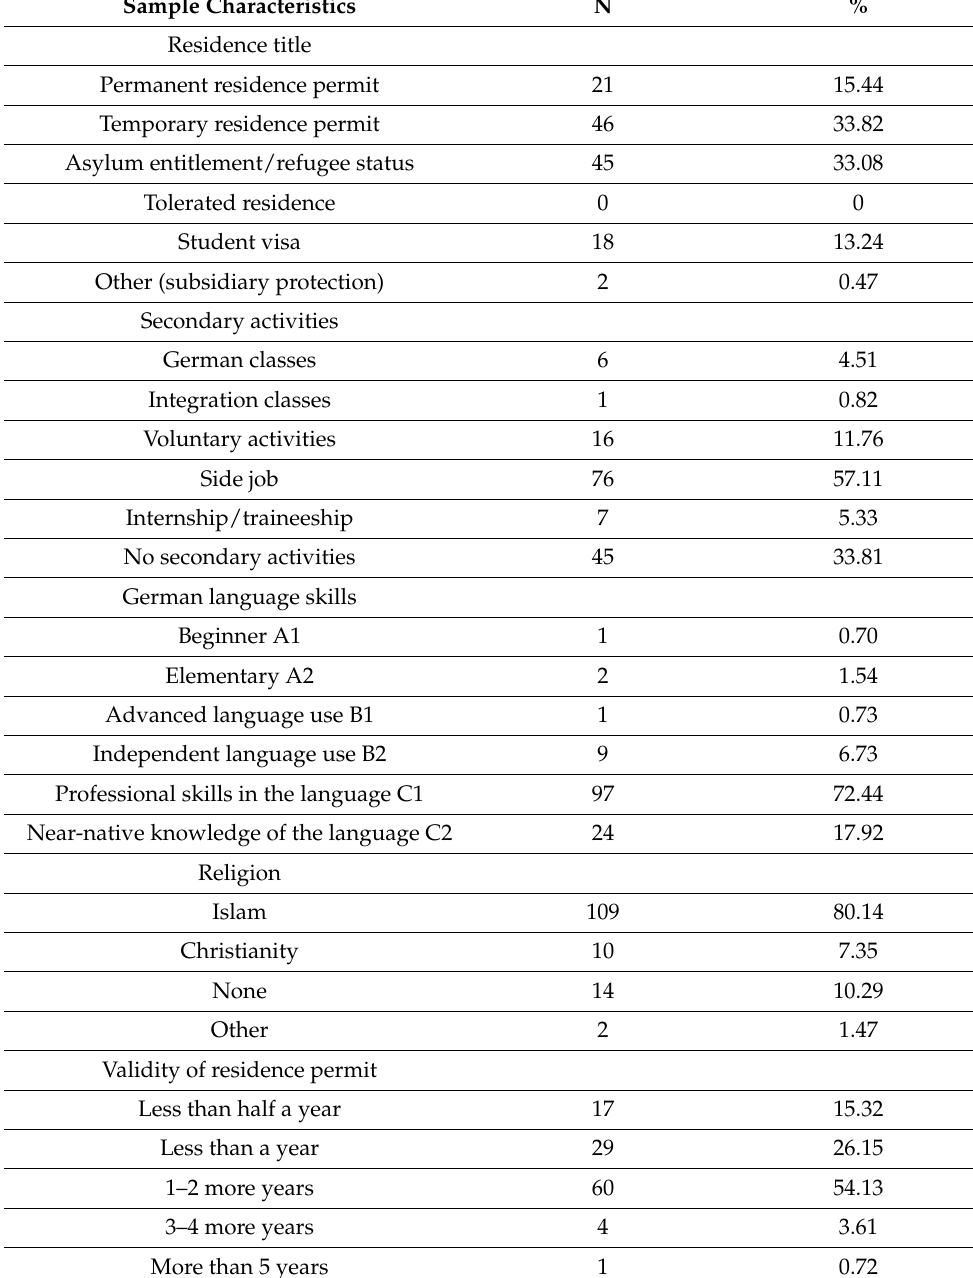
Table 1. Cont . Sample